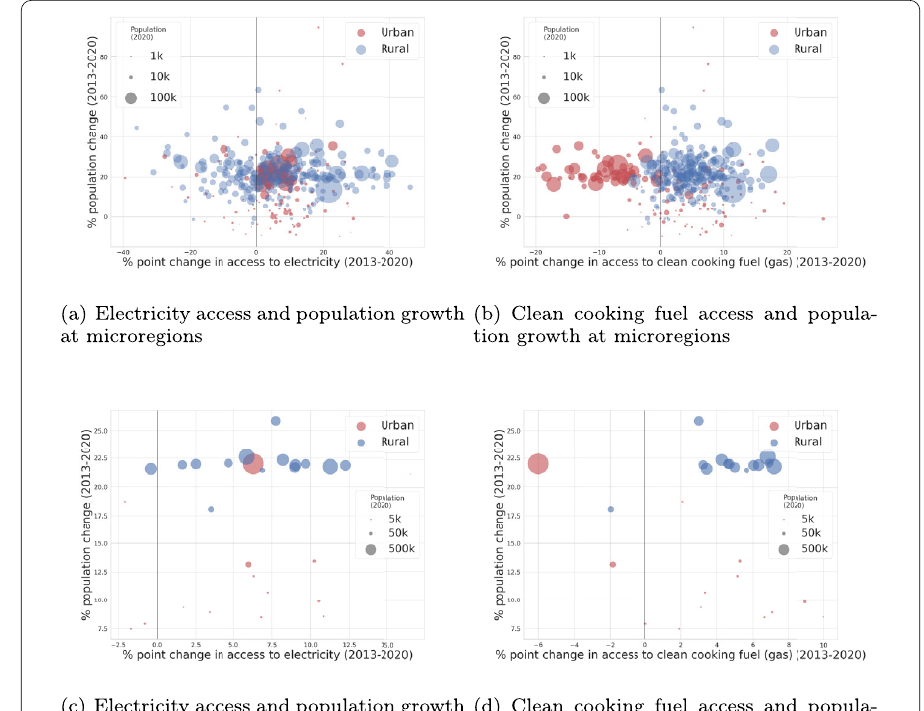
Figure 4 Changes in access to electricity and clean cooking fuels (in percentage point) related to population change (in percentage) from 2013-2020 at microregions (shown in ( a ) for electricity and ( b ) for clean cooking fuel) and aggregated to regions (shown in ( c ) for electricity and ( d ) for clean cooking fuel). Red points denote urban and blue for rural. Size of the circles denote their population. These plots highlight hot-spots where